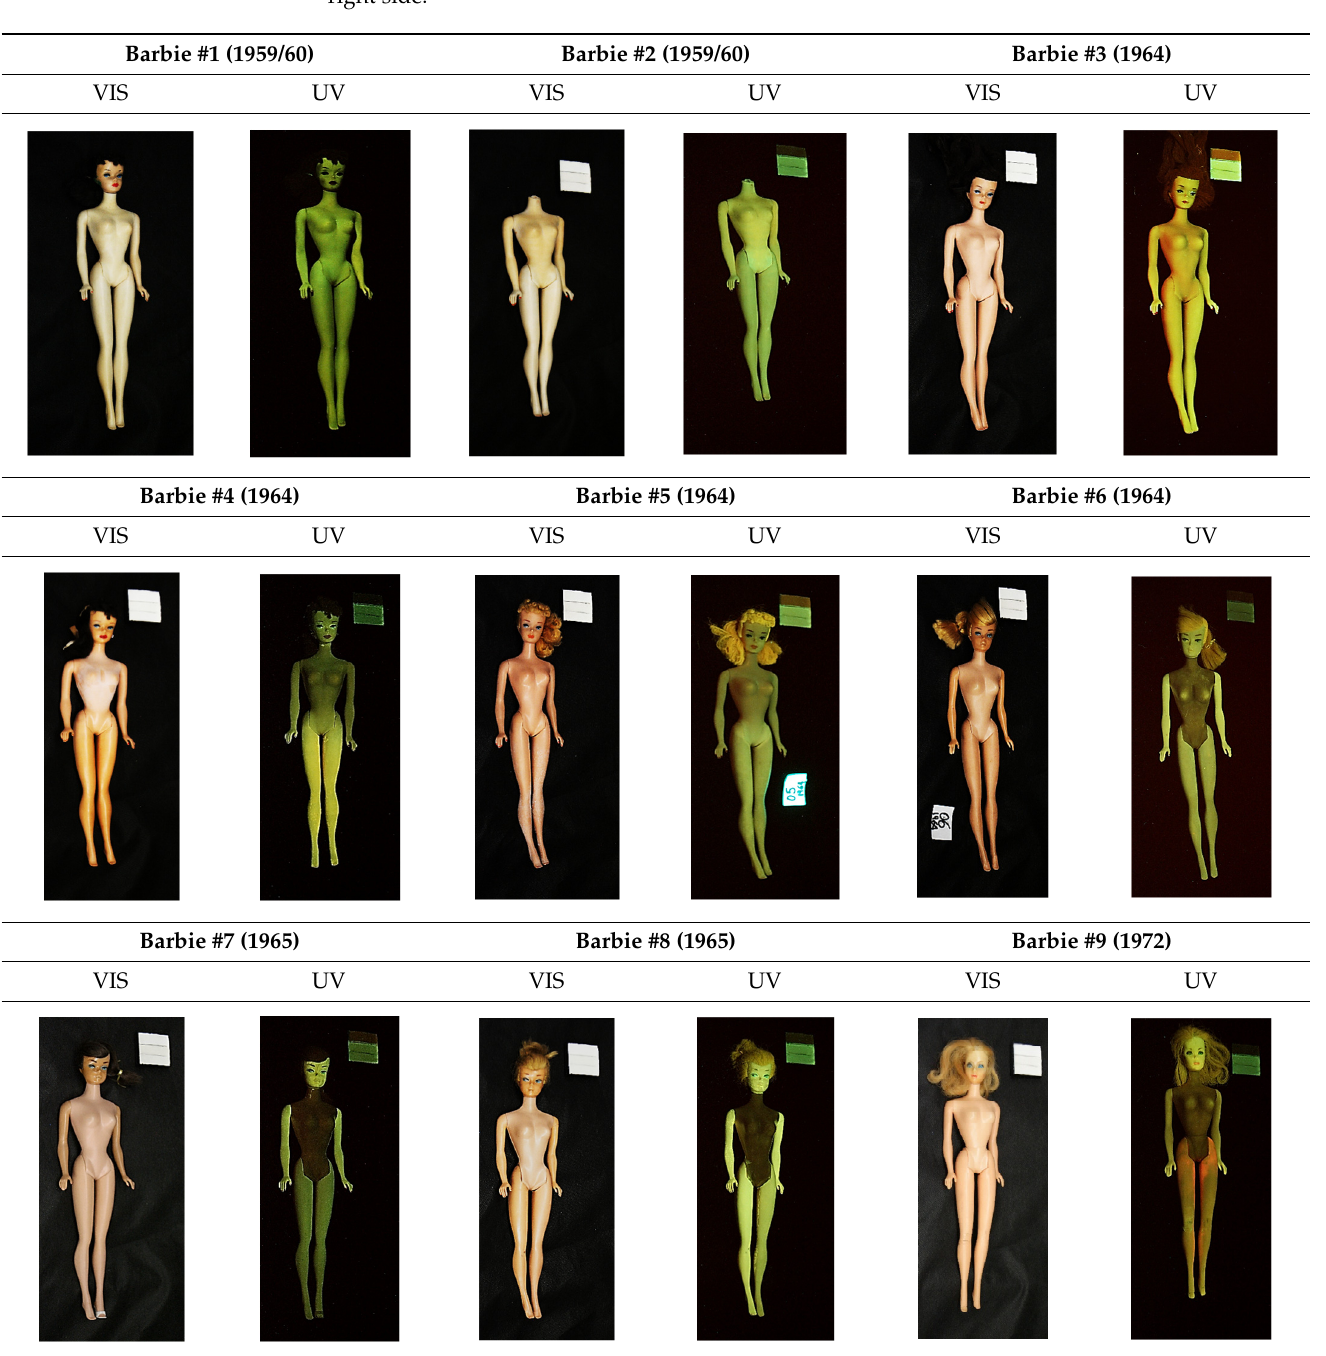
Table 1. Multispectral images (VIS and UV) of the 15 Barbies including a VIS/UV reference standard: right side.